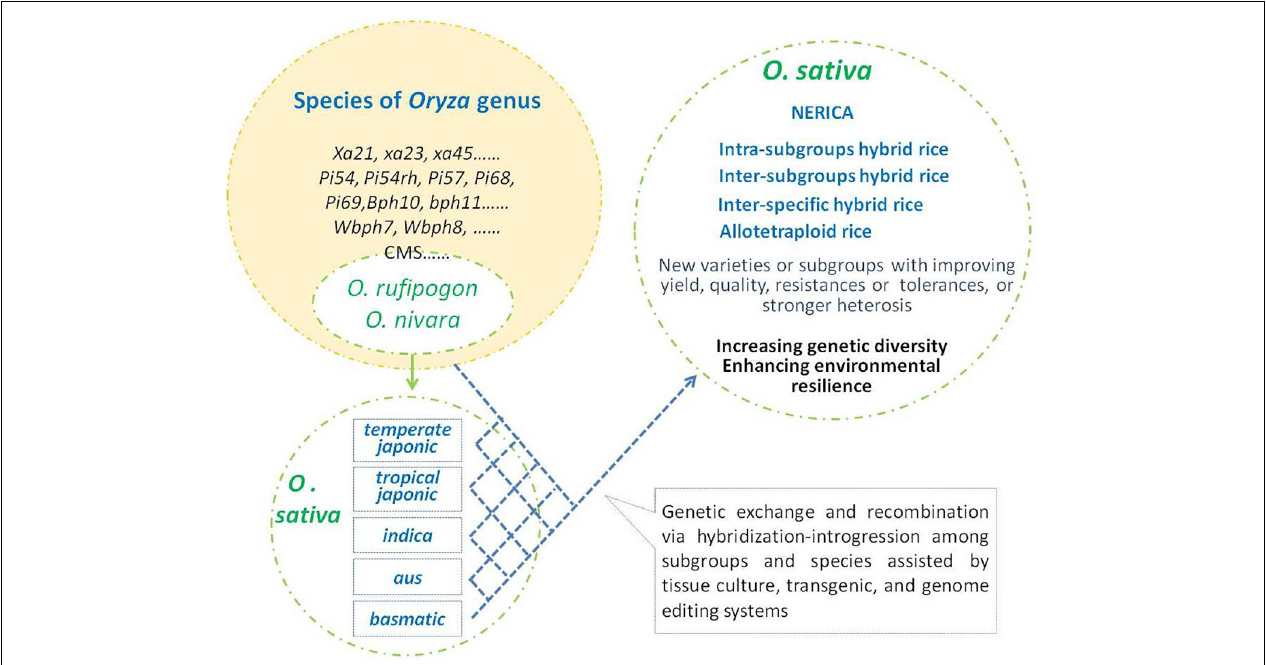
FIGURE 2 | Artificial hybridization-introgression for genetic improvement of Oryza sativa. O. sativa group was descent from Oryza rufipogon and Oryza nivara. Species of Oryza genus including O. rufipogon and O. nivara are rich in genetic diversity and favorable traits/alleles. Some elite genes/alleles were transferred into Asian cultivated rice and gained several breakthroughs in rice breeding. Further hybridization-introgression among interspecies and inter-subgroups will provide more chances to enlarge genetic diversity and gain breeding achievements in O. sativa .